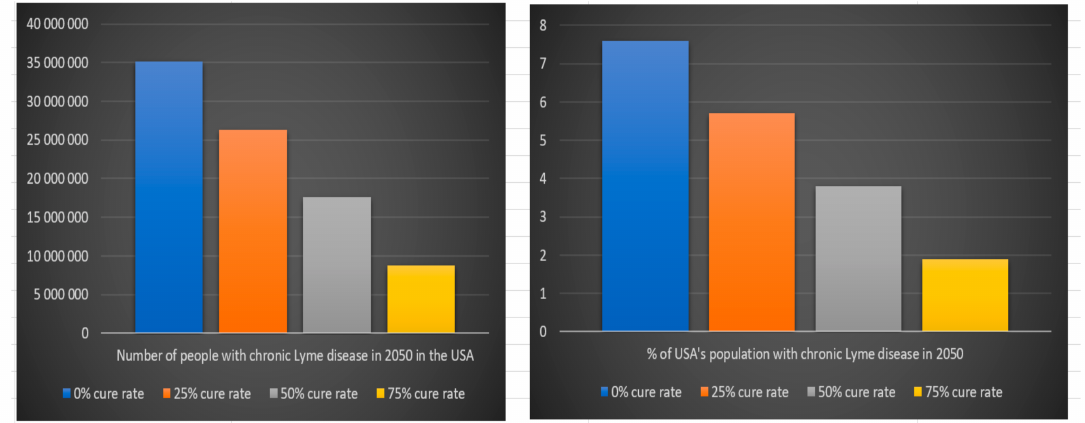
Figure 17. Number of people with chronic Lyme disease in 2050 in the USA